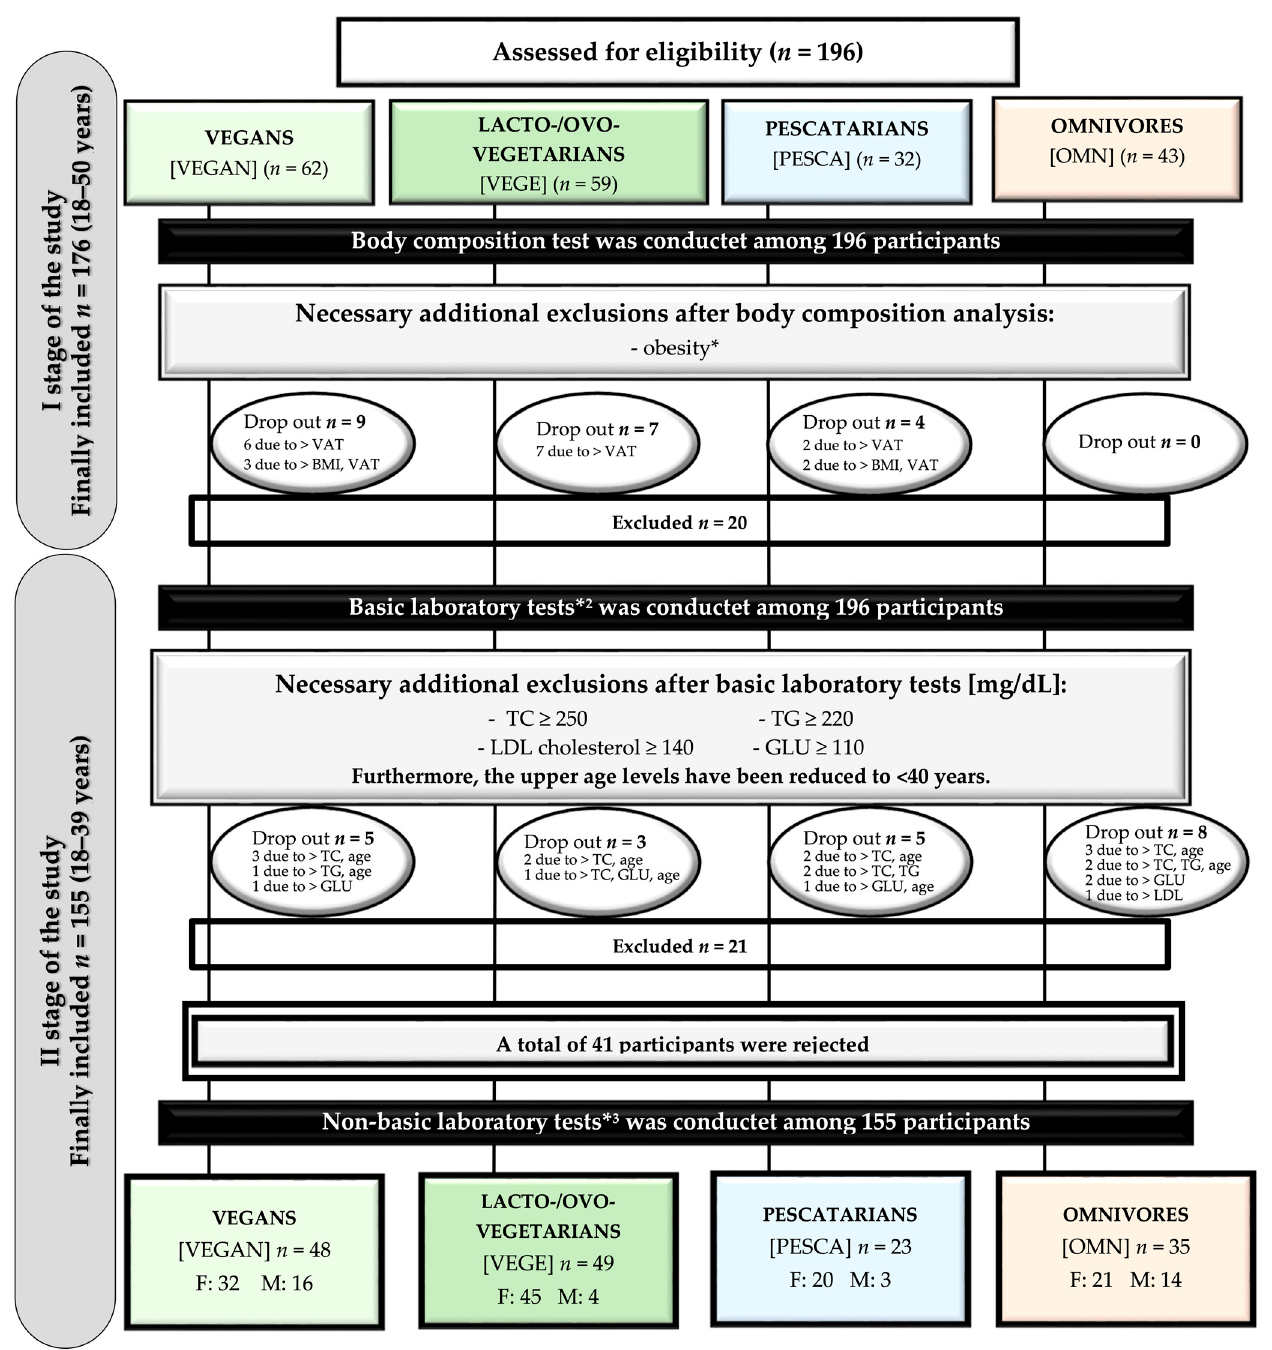
Figure 2. The scheme of recruiting participants. Abbreviations: F — Female, M — Male. * not every